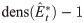
Observed dominance and robustness and density at the balance point of the networks formed by conference communities in DBLP as the networks grows in size over time.To improve the presentation, we plot dens(E^t*)−1 for the density measure.